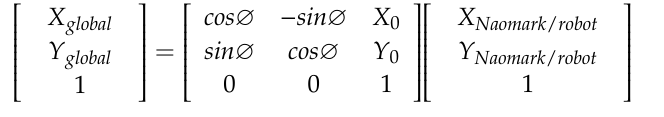
Figure 12. NAO mark global coordinates. In general, a 2D transformation between two frames is a combination of rotation and translation, written as: